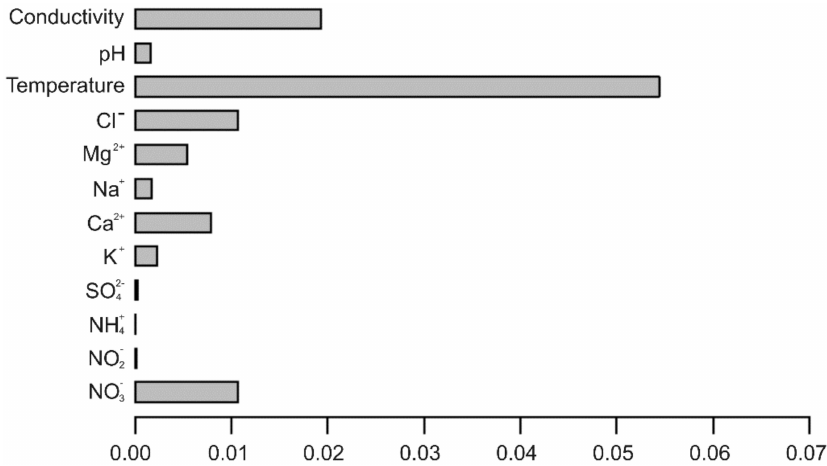
Figure 4. Bar graph of the relative importance of di ff erent variables in generating classification trees, when five variables are repeatedly drawn at